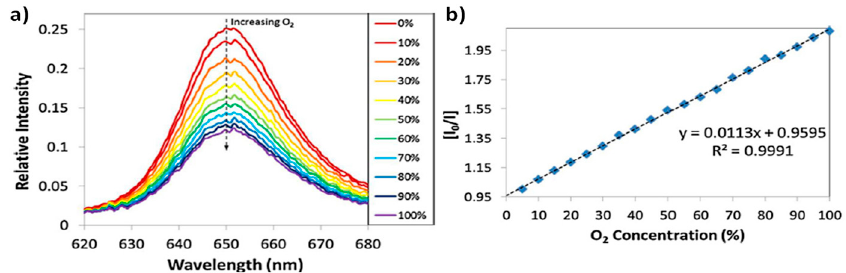
Figure 3. ( a ) Luminescence signal from the sensor when it is exposed to different increasing oxygen concentrations; ( b ) Stern-Volmer plot obtained from the sensor for increasing oxygen 5% steps. Inset the linear approach with the R 2 parameter. Reprinted with permission from Ref. [27].